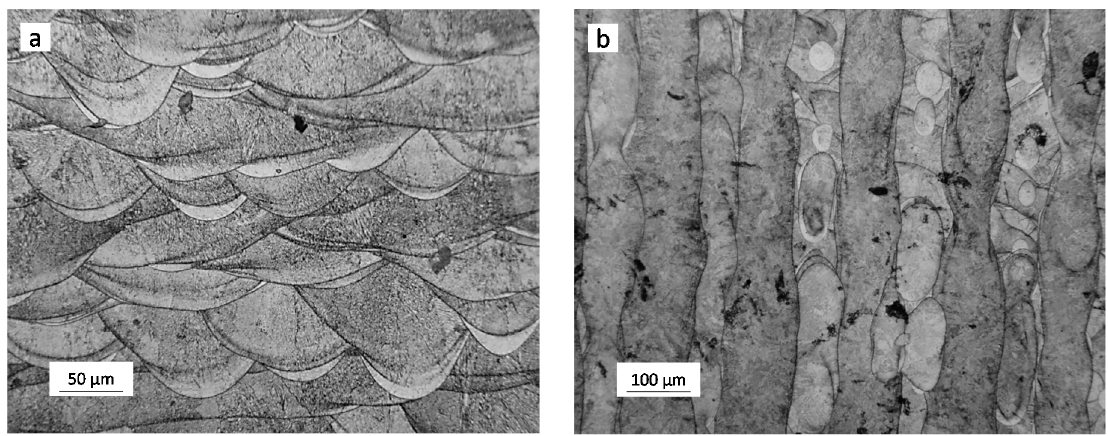
Figure 3. Optical images of the as built microstructure of the steel investigated. ( a ) Lateral view; and ( b ) top view.